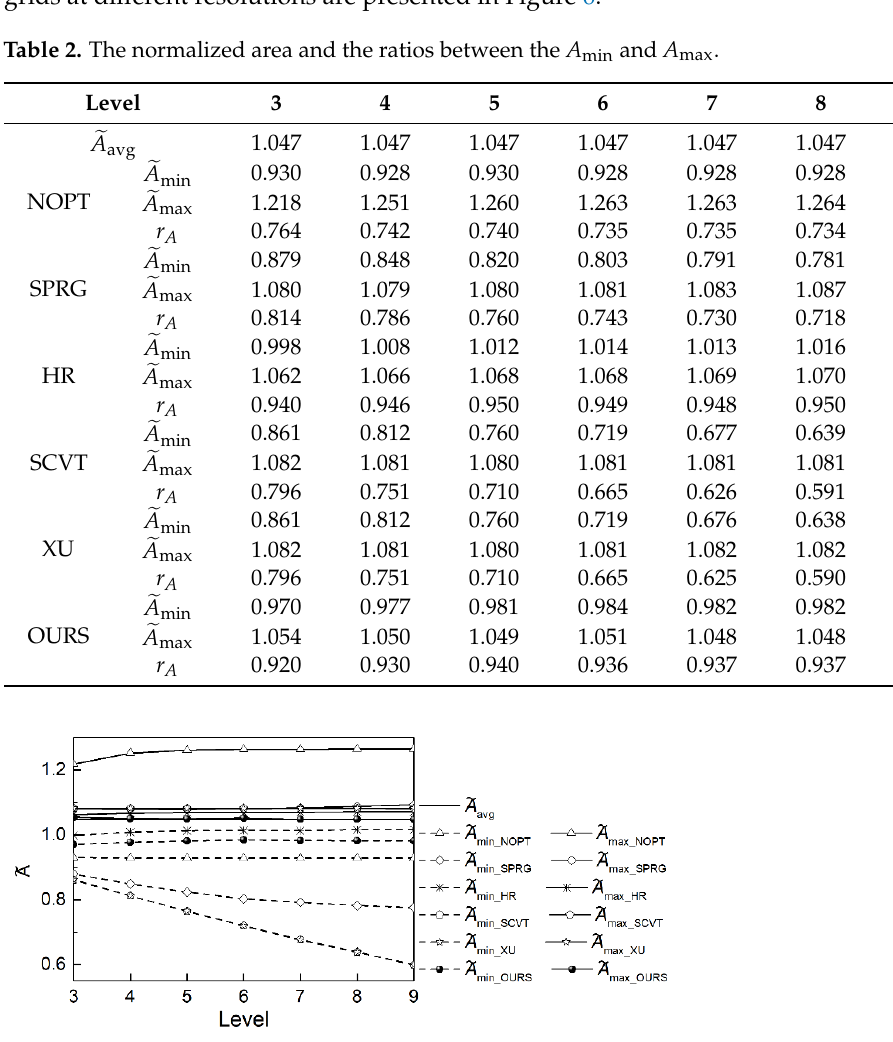
Figure 5. of different grids. Figure 5. (cid:101) A min and (cid:101) A max of different grids. Figure 5.